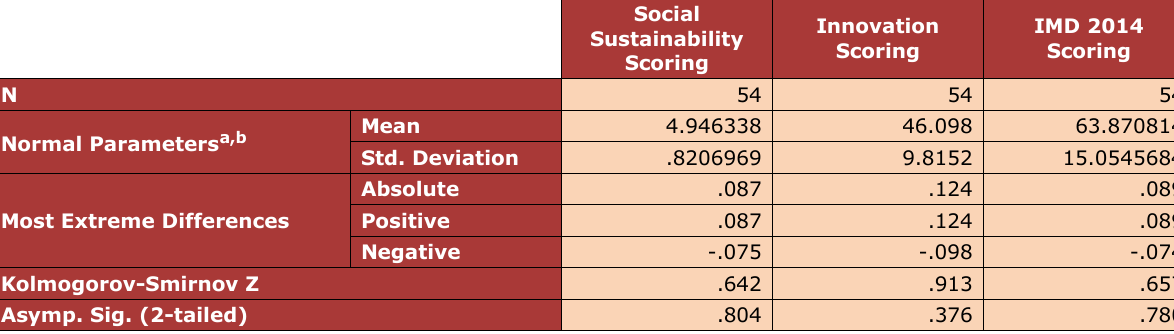
Table 1. One-Sample Kolmogorov-Smirnov